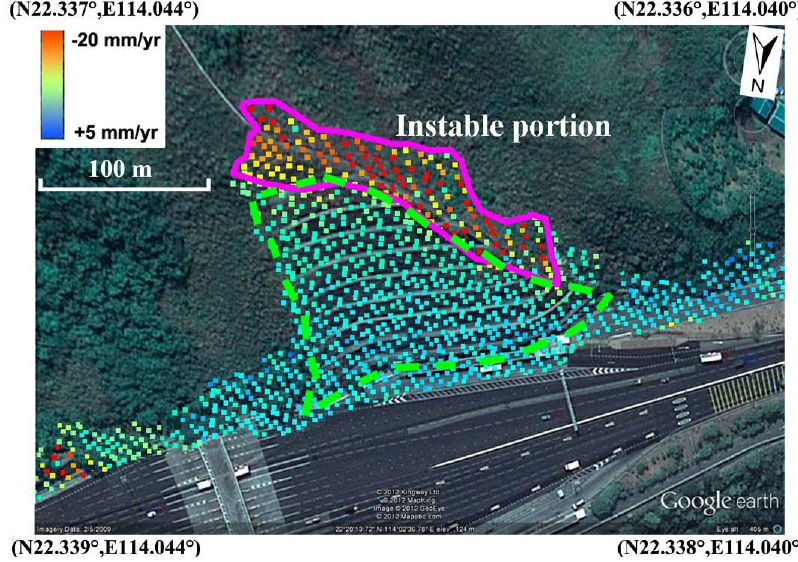
Figure 10. Slope-projected motion rates of a consolidated slope nearby the Lantau Highway in a hot-spot of Disneyland, which is superimposed on the Google Earth (GE) image. Unstable surface (within the boundary marked by the pink polygon) still exists nearby the consolidated one, showing the effectiveness and importance of preventive measures (marked by the green